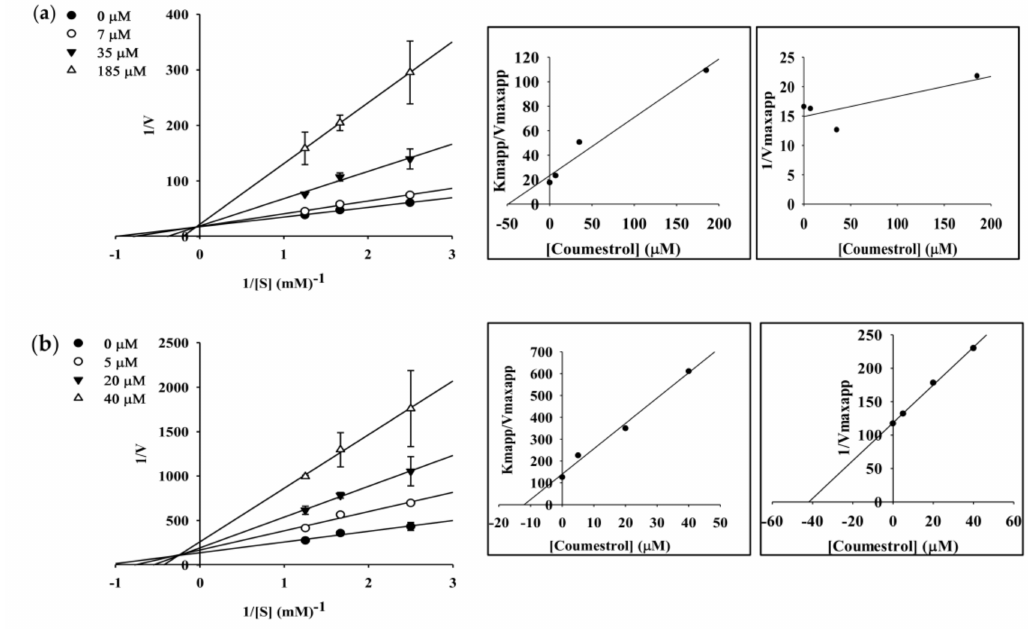
Figure 3. Lineweaver-Burk plots and secondary plots for AChE ( a ) and BChE ( b ) inhibition of coumestrol.